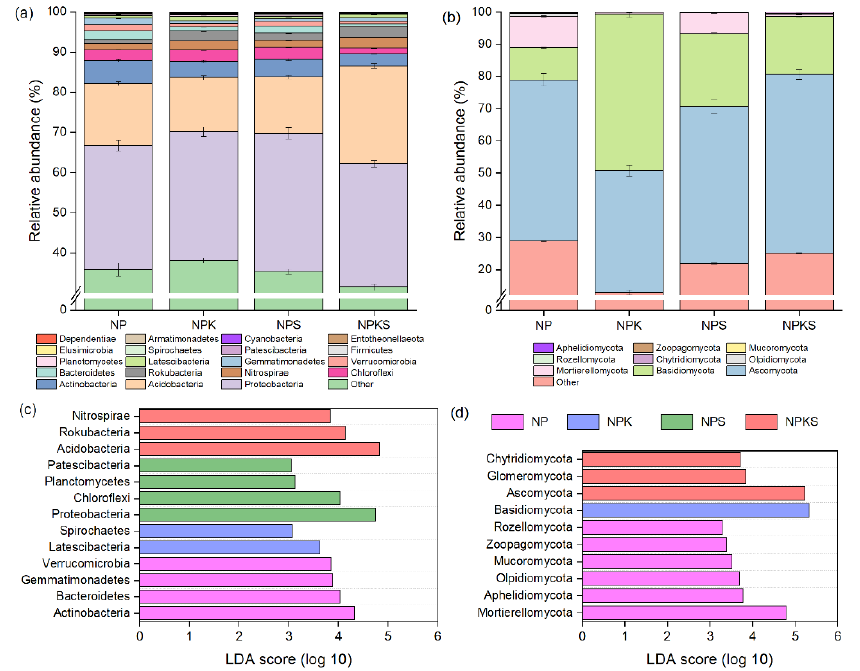
Figure 2. The relative abundance of major taxonomic groups for ( a ) bacteria and ( b ) fungi at the phylum level and the error bars are standard deviation and significant changes in bacterial ( c ) and fungal ( d ) key phylotypes identified using linear discrimination analysis effect size.